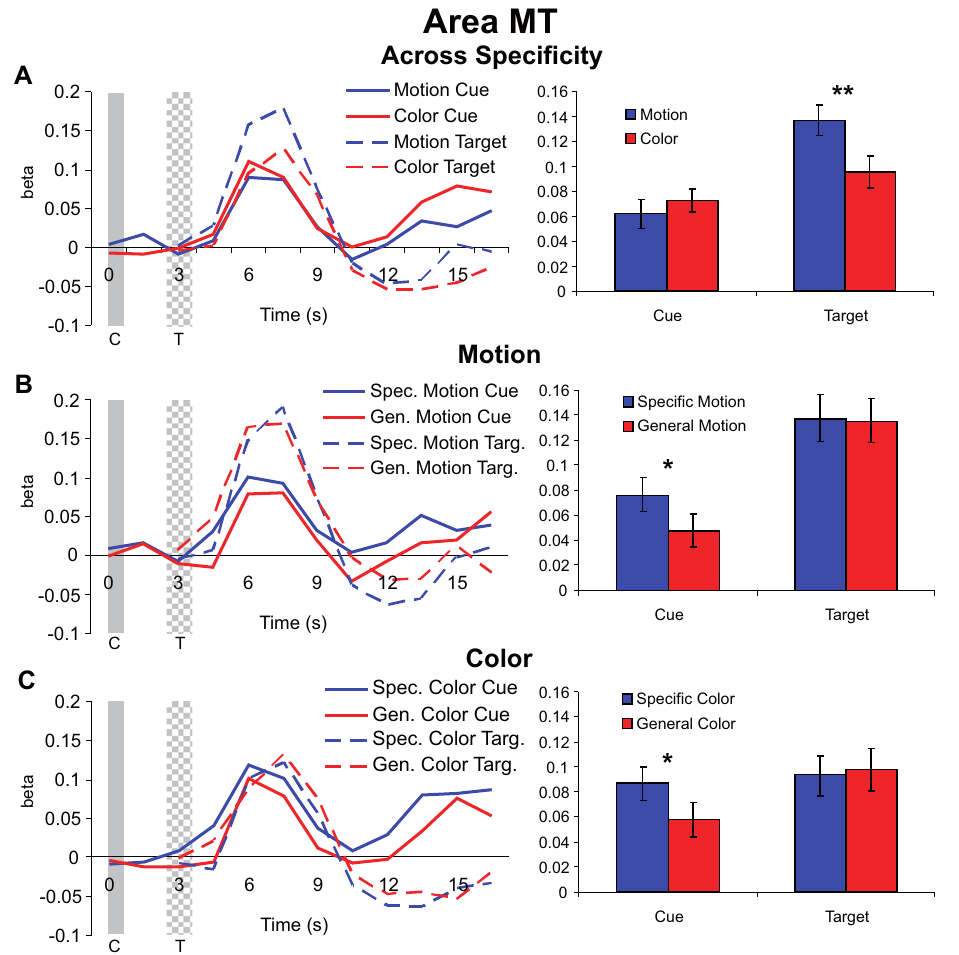
Figure 4. Cue and target responses in area MT. Left column shows BOLD response time course estimates (beta weights) in MT. The solid and checkered gray bars represent the cue (C) and target (T) onsets and offsets, respectively. The right column shows the amplitudes of cue and target responses averaged over the three TRs around the peak of the hemodynamic response (see “Materials and methods” section). All individual cue and target responses are signifi cantly different from the zero baseline. (A) Hemodynamic responses collapsed across specifi c feature and general dimension trials for motion and color cues and targets in MT. Although cue responses for motion and color conditions were not signifi cantly different, there was a signifi cant difference in target processing with attention (cued and attending for motion vs. color) in MT. Note that because the stimulus displays were identical for motion and color attention conditions, differences in target processing between motion and color refl ect the effects of feature-based attention and not merely differences in selectivity for motion vs. color stimuli in MT. (B) Hemodynamic responses for motion specifi c feature and general dimension cues and targets in MT. The selective attention (cuing) effect here is the difference between the informative specifi c feature cue trials (for cues and targets) and the non-informative general dimension cue trials (for cues and targets). (C) Hemodynamic responses for color specifi c feature and general dimension cues and targets, also in